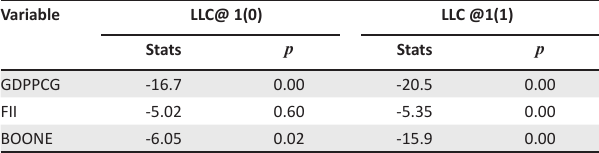
TABLE 3: Levin Lu and Chu unit root test @ I (0) and 1(1) level.